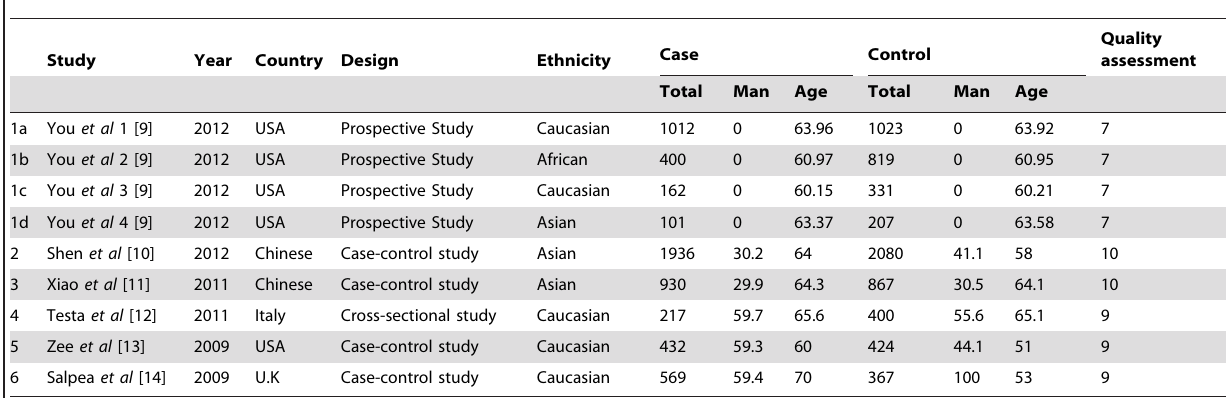
Table 1. Characteristics of studies examining the association between telomere length and T2DM included in the meta-analysis.